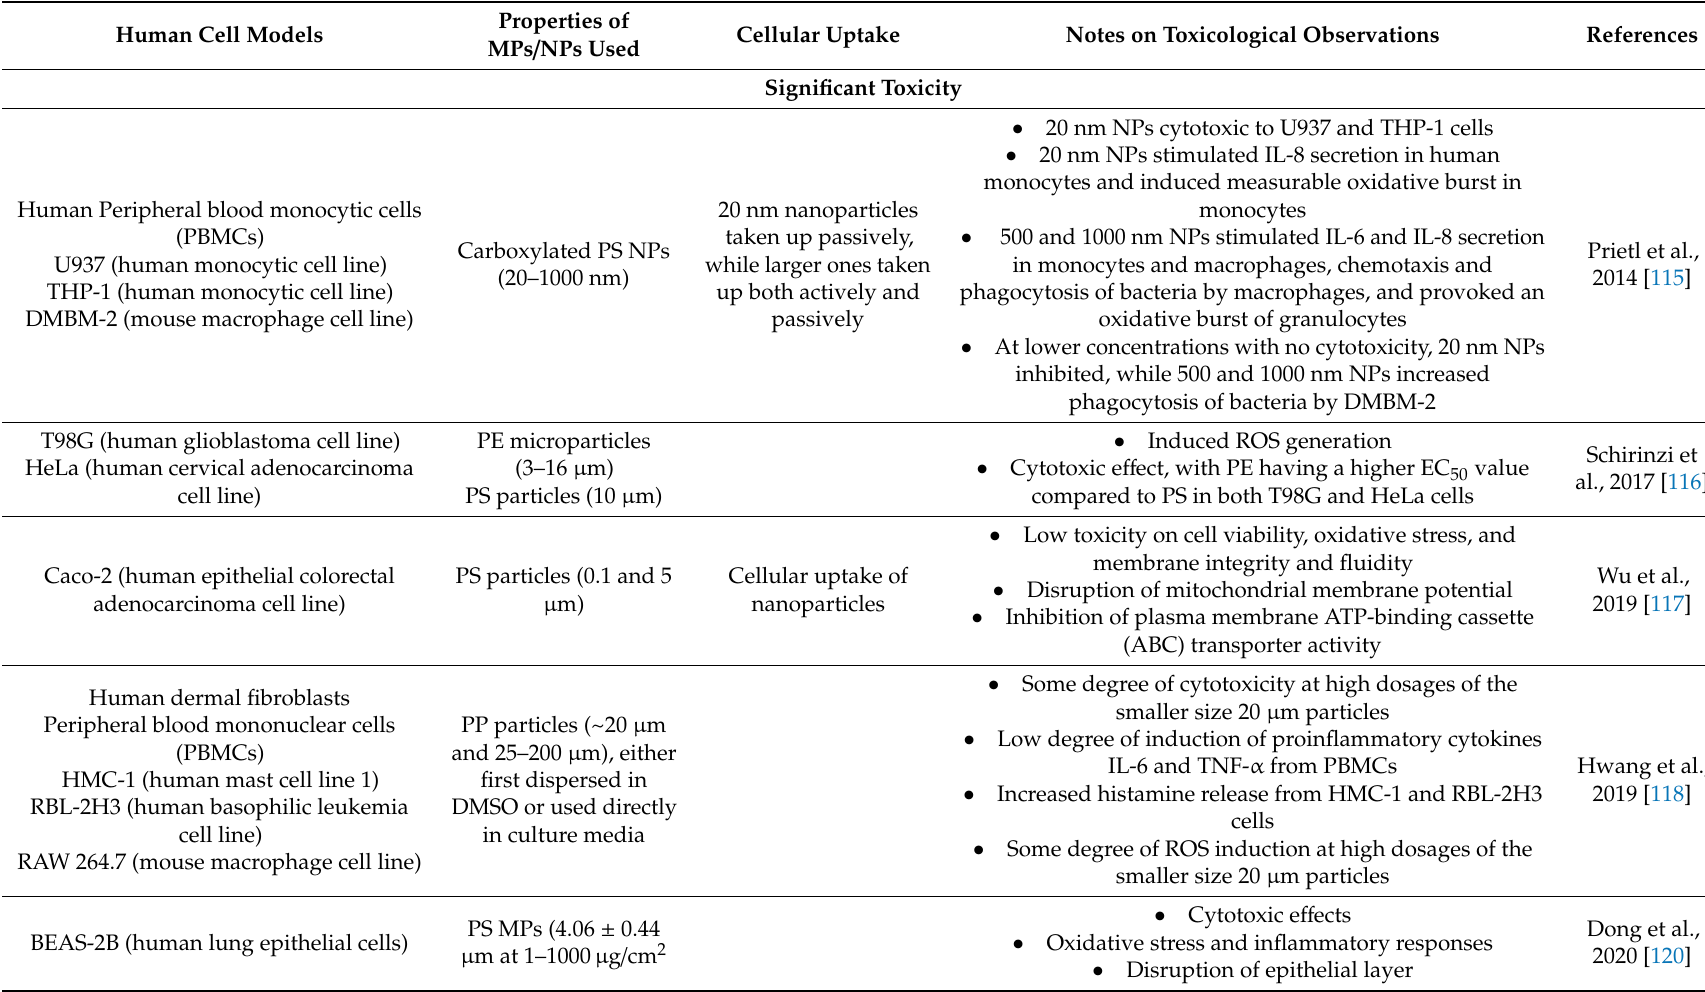
Table 3. A summary of notable toxicological findings associated with MPs / NPs in human cells. PS, polystyrene; PE, polyethylene; PVC, polyvinylchloride; NPs, nanoplastics ( < 1 µ m); MPs,